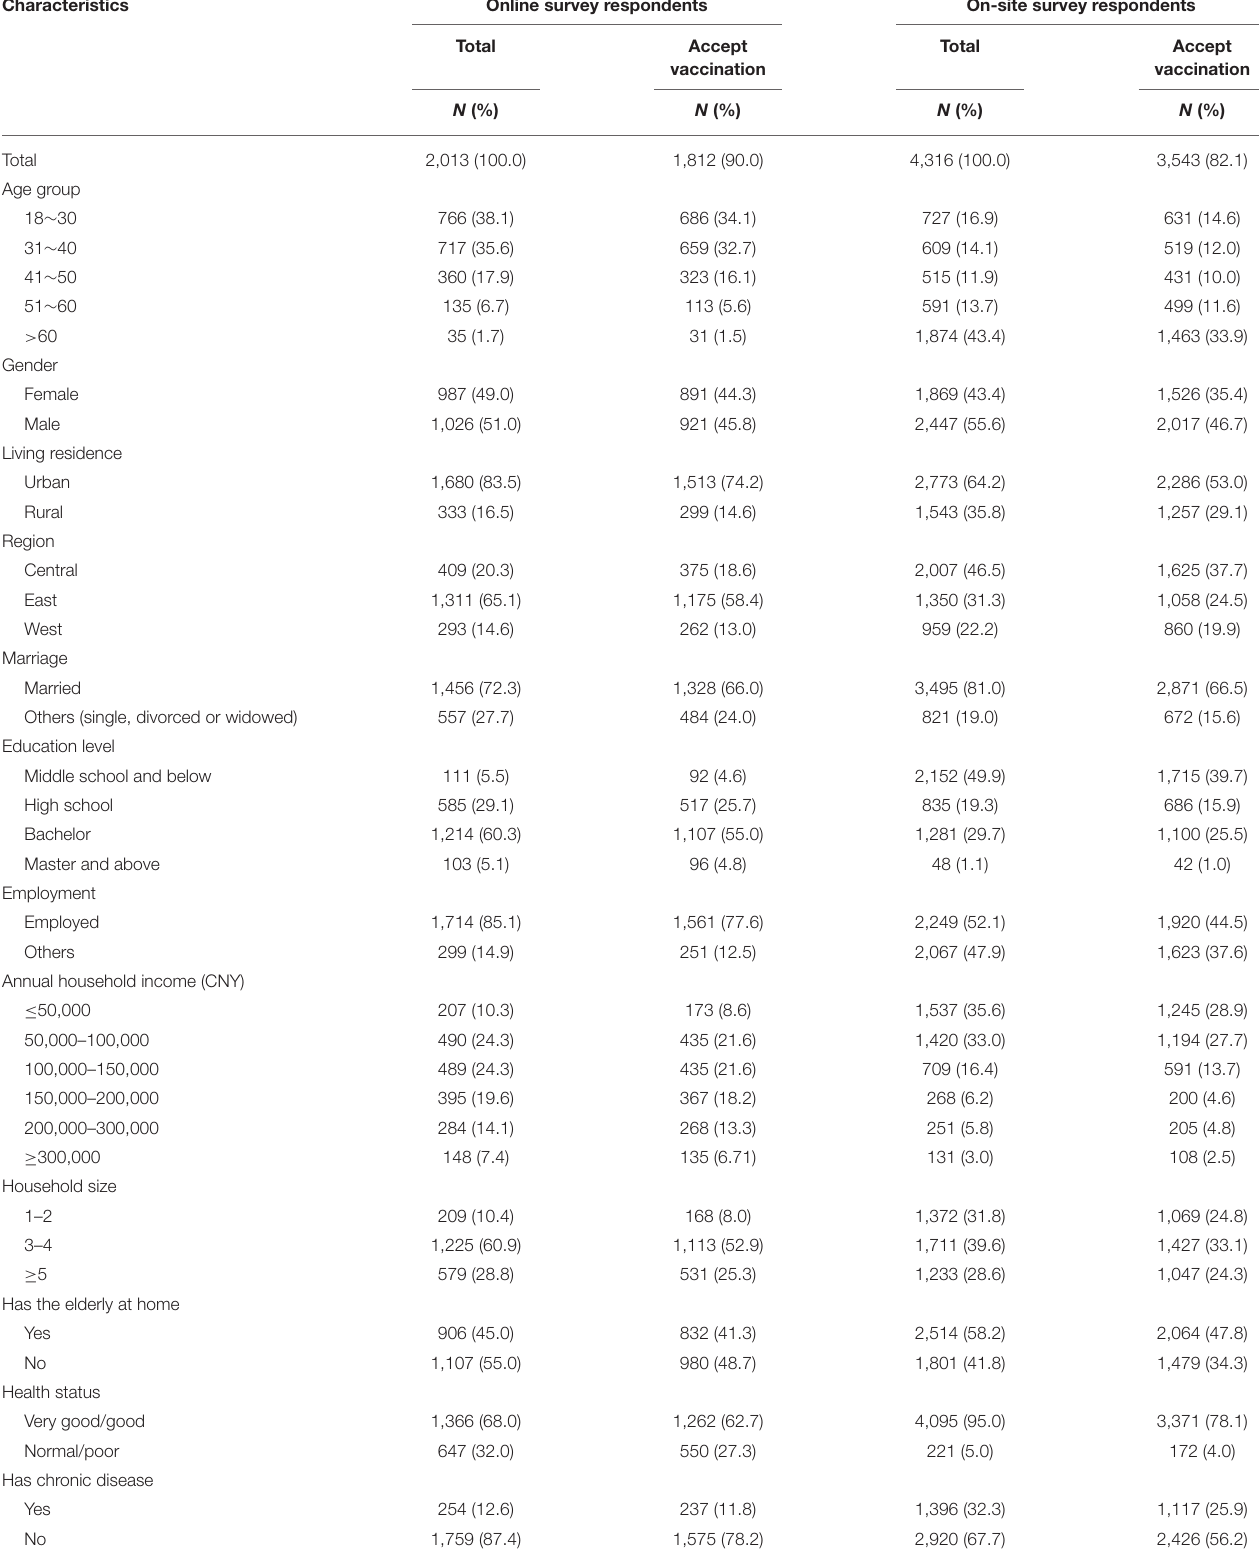
TABLE 1 | Characteristics of survey respondents and the number of respondents who accepted